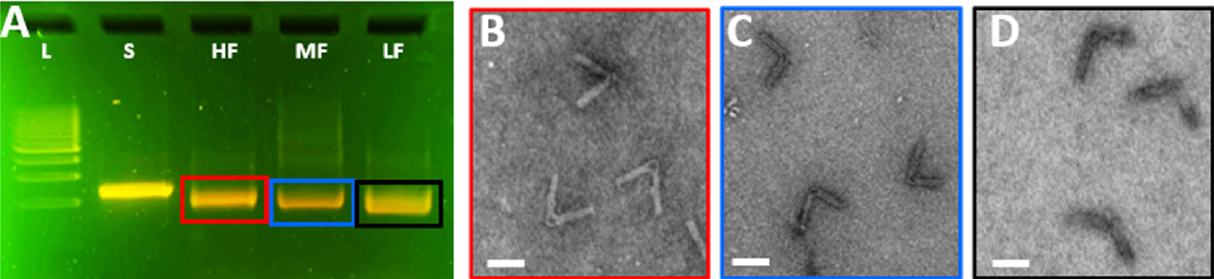
Figure 4. Analysis of CHJ in classroom modules. ( A ) Gel electrophoresis image of the three different CHJ configurations folded with the classroom protocol; image taken in the MiniOne agarose gel electrophoresis kit. From left to right: 1 kb ladder, 8064 bp scaffold, CHJ.HF, CHJ.MF, CHJ.LF. ( B ) TEM image of the CHJ.HF cut from the gel in panel A. ( C ) TEM image of the CHJ.MF cut from the gel in panel A. ( D ) TEM image of the CHJ.LF cut from the gel in panel A. Scale bars = 50 nm.